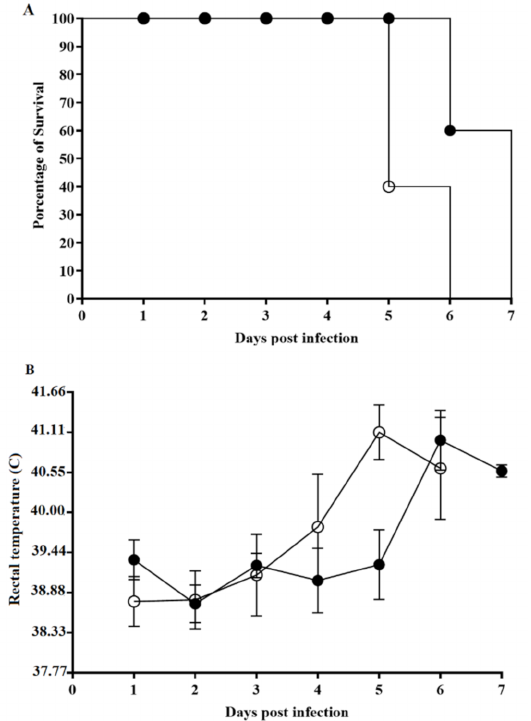
Figure 5. Evolution of mortality ( A ) and body temperature ( B ) in animals (5 animals/group) intra- muscularly (IM) infected with 10 2 HAD 50 of either ASFV-G- ∆ MGF110-1L (filled symbols) or parental ASFV-G (open symbols). Significant differences ( p -value = 0.0201) in the survival course between groups of pigs were found using the test de Long-rank (Mantel-cox test). No statistical differences were found in body temperatures between pigs in both groups, when evaluated by the Holm-Sidak method ( α = 0.05). All calculations were conducted using the software Graphpad Prism version